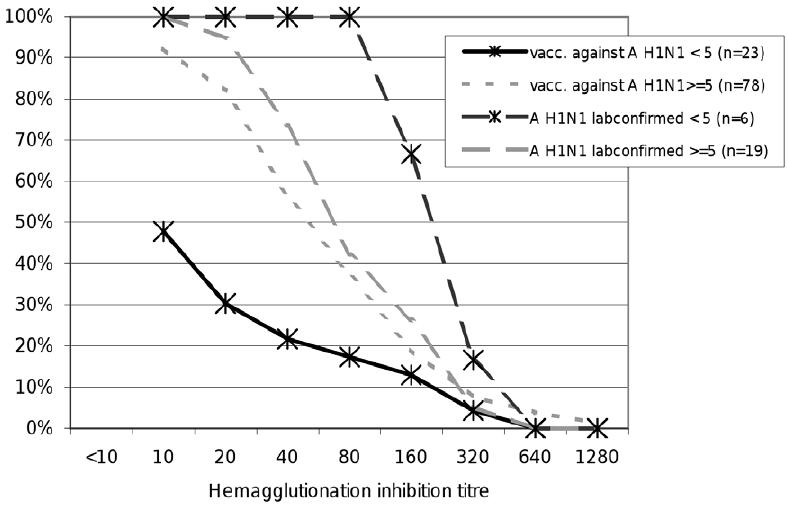
Figure 2. Reverse cumulative distribution curves of children vaccinated against the A (H1N1) 2009 virus , 5 years (n=23), . =5 years (n=78) and in children with laboratory-confirmed A (H1N1) 2009 infection , 5 years (n=6), . =5 years (n=19). Vaccinated children and children with laboratory-confirmed A (H1N1) infection were mutually exclusive. Children vaccinated against the A (H1N1) 2009 virus exhibit lower titers compared to children with laboratory-confirmed A (H1N1) 2009 infection. This can be observed in both age groups with greater difference in younger children.